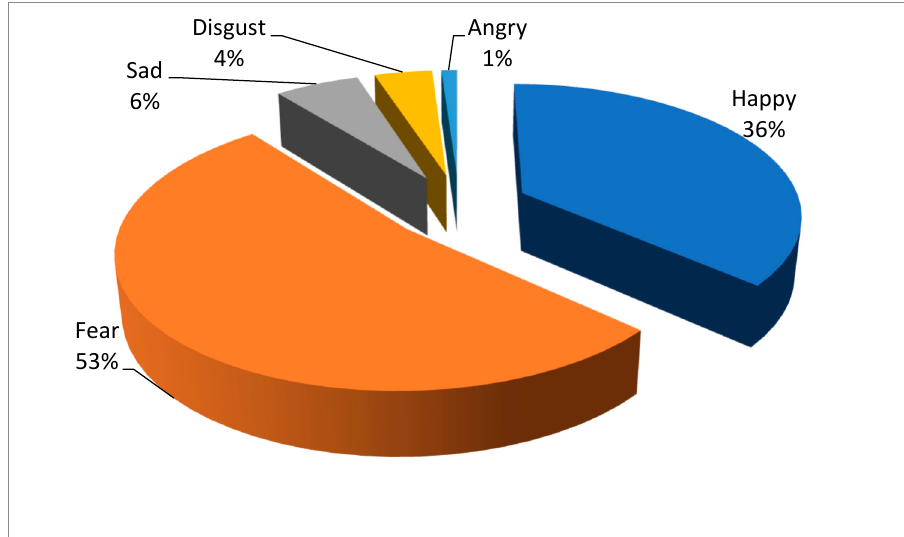
Figure 2. Distribution of emotional